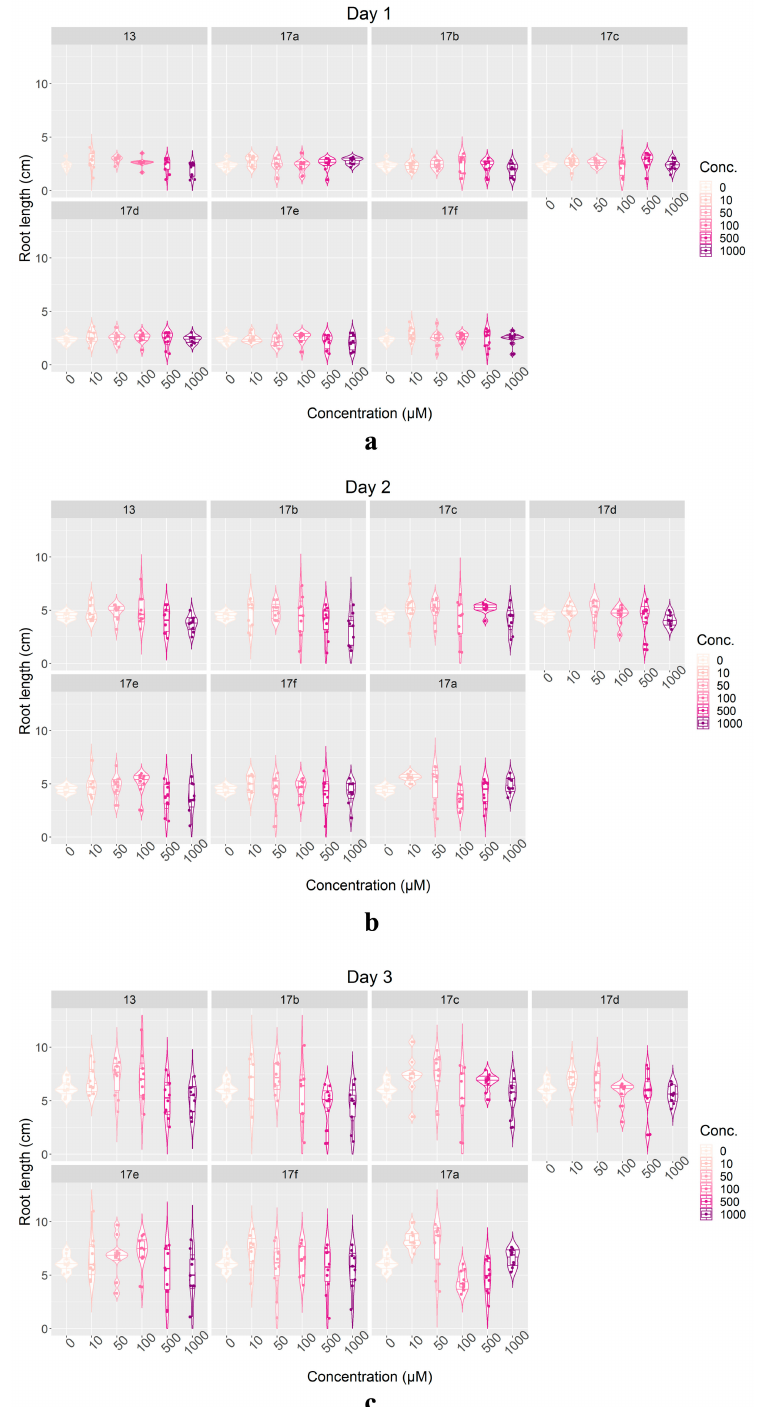
Figure 7. Violin plots (with boxplots inside to indicate quartiles) describing the Triticum root length as a function of the tested compounds and concentrations, in: ( a ) day one, ( b ) day two, ( c ) day three of